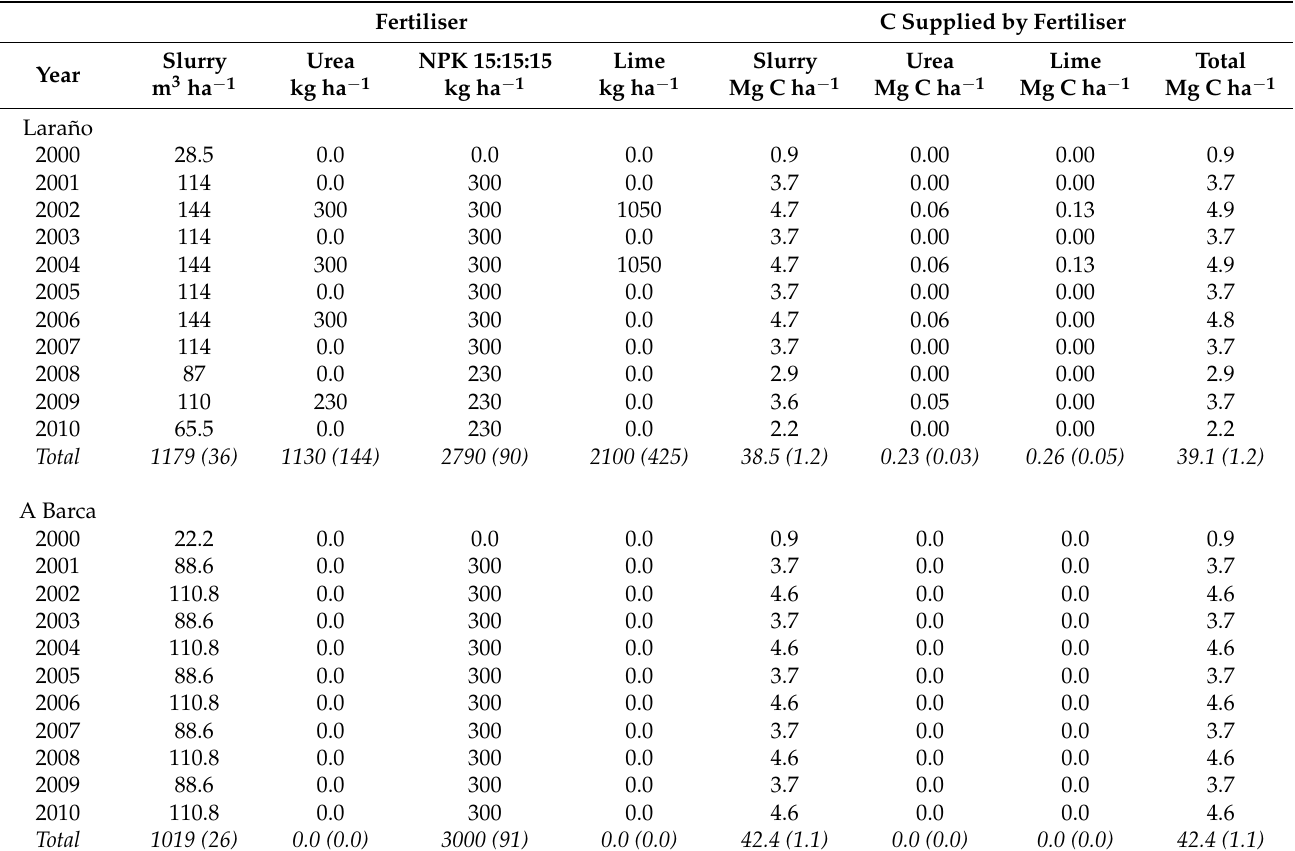
Table 3. Amounts of fertilisers and C supplied by the fertilisers in Laraño and A Barca. (Total: mean values and standard deviation in brackets).